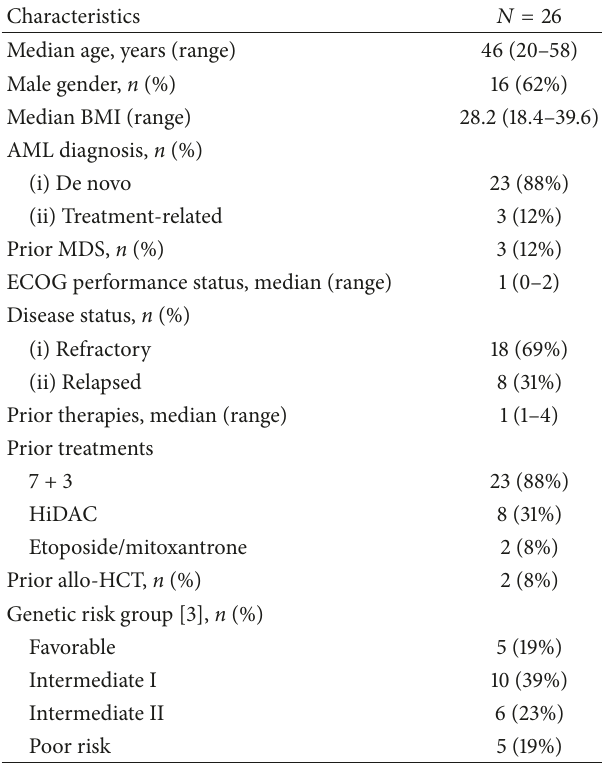
Table 1: Patient characteristics.